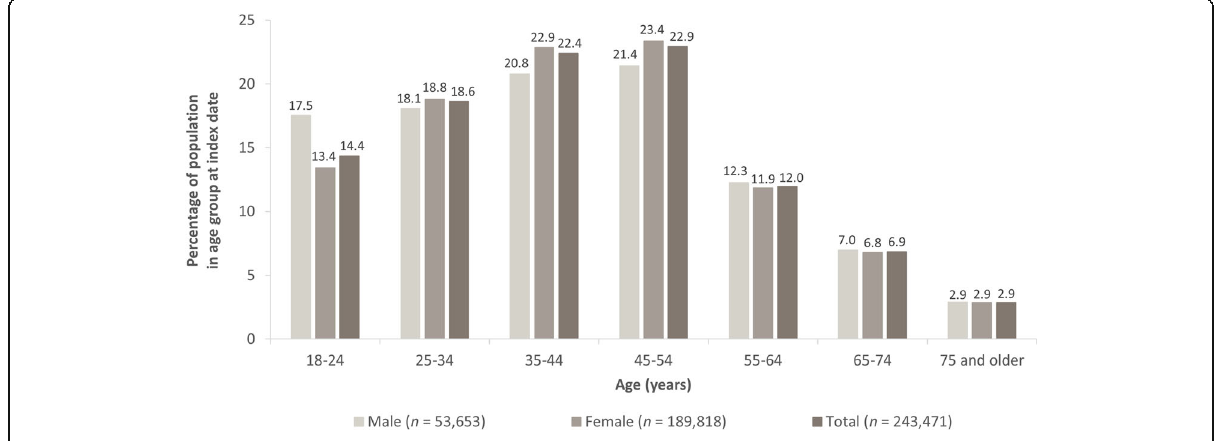
Fig. 3 Age distribution of patients with migraine in the German Company Sickness Fund Database 2008 to 2016